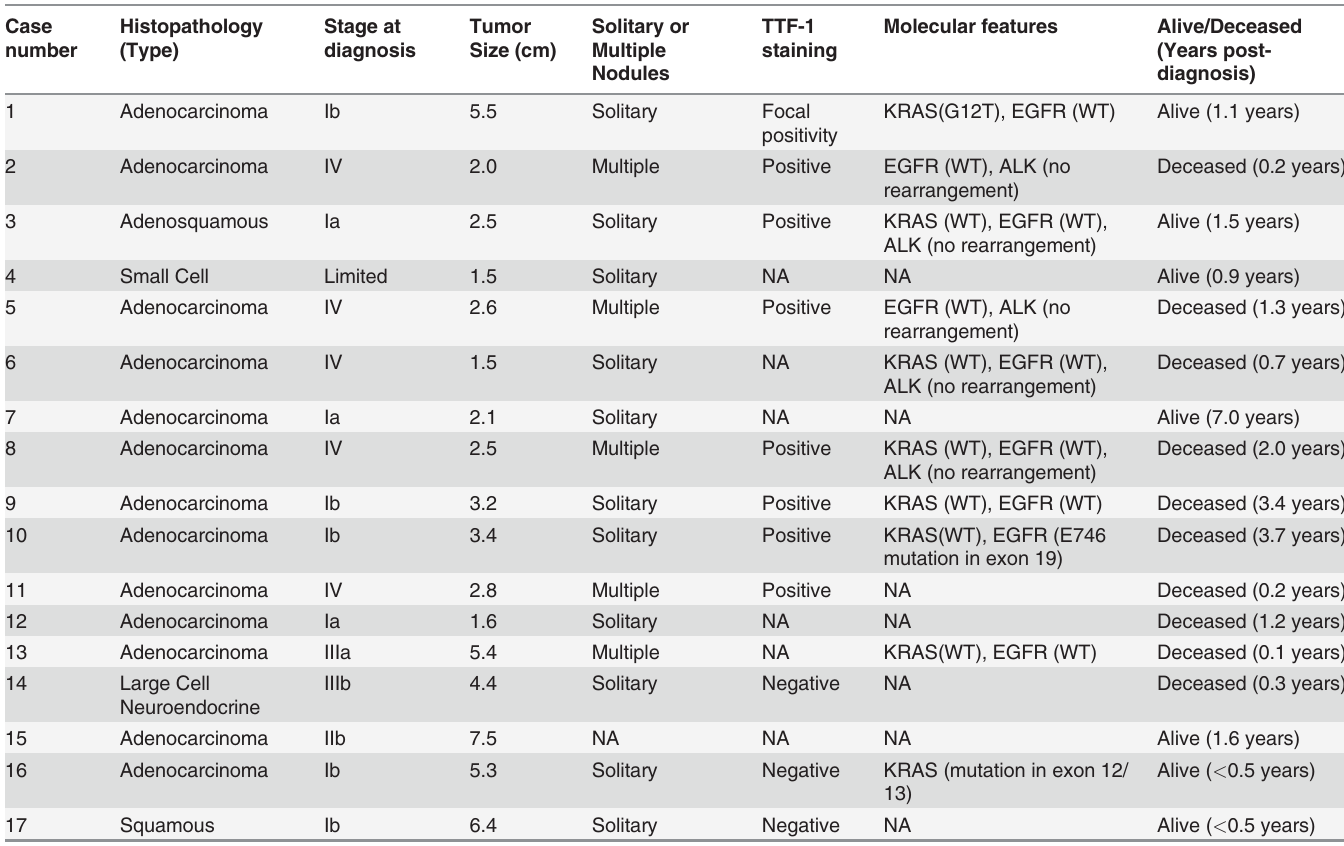
Table 3. Tumor characteristics and